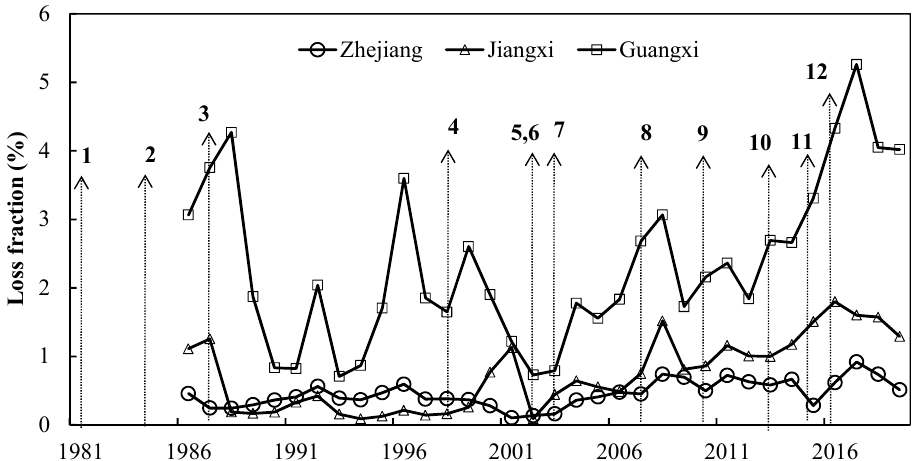
Figure 12. The timelines of the major forestry policies and interannual variations in forest loss area in the Zhejiang, Jiangxi, and Guangxi Provinces. 1: the three-determination policy (the first try for collective forest tenure reform) (1981); 2: the first Forestry Law of the People’s Republic of China (1984); 3: policy for enhancing forest management and ban on indiscriminate tree felling (1987); 4: the trial of Natural Forest Conservation Program (NFCP) (1998); 5: Grain-to-Green (or Green for Grain) Policy (GTGP) (2002); 6: Project for Fast-growing and High-yield Plantation in Key Areas (FHPKA) (2002); 7: the trial of Collective Forest Tenure Reform (CFTR) (2003); 8: the full implementation of CFTR (2008); 9: the full implementation for NFCP (2010); 10: policy for public welfare forest classification and management (2013); 11: reform of the state-owned forest farms (RSFF) (2015); 12: the amendment of Forestry Law (CFTR, NFCP, and other policies were added into law) (2016).